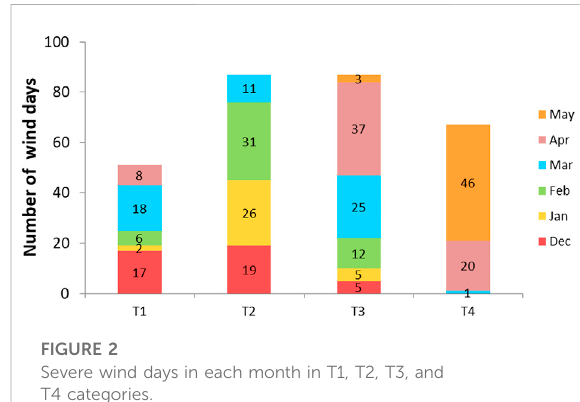
FIGURE 2 Severe wind days in each month in T1, T2, T3, and T4 categories.